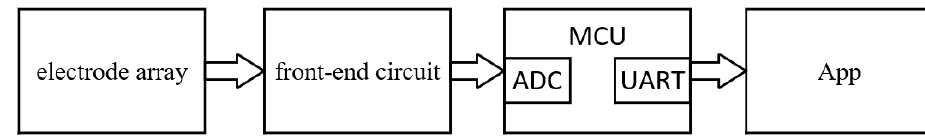
Figure 1. System block diagram.